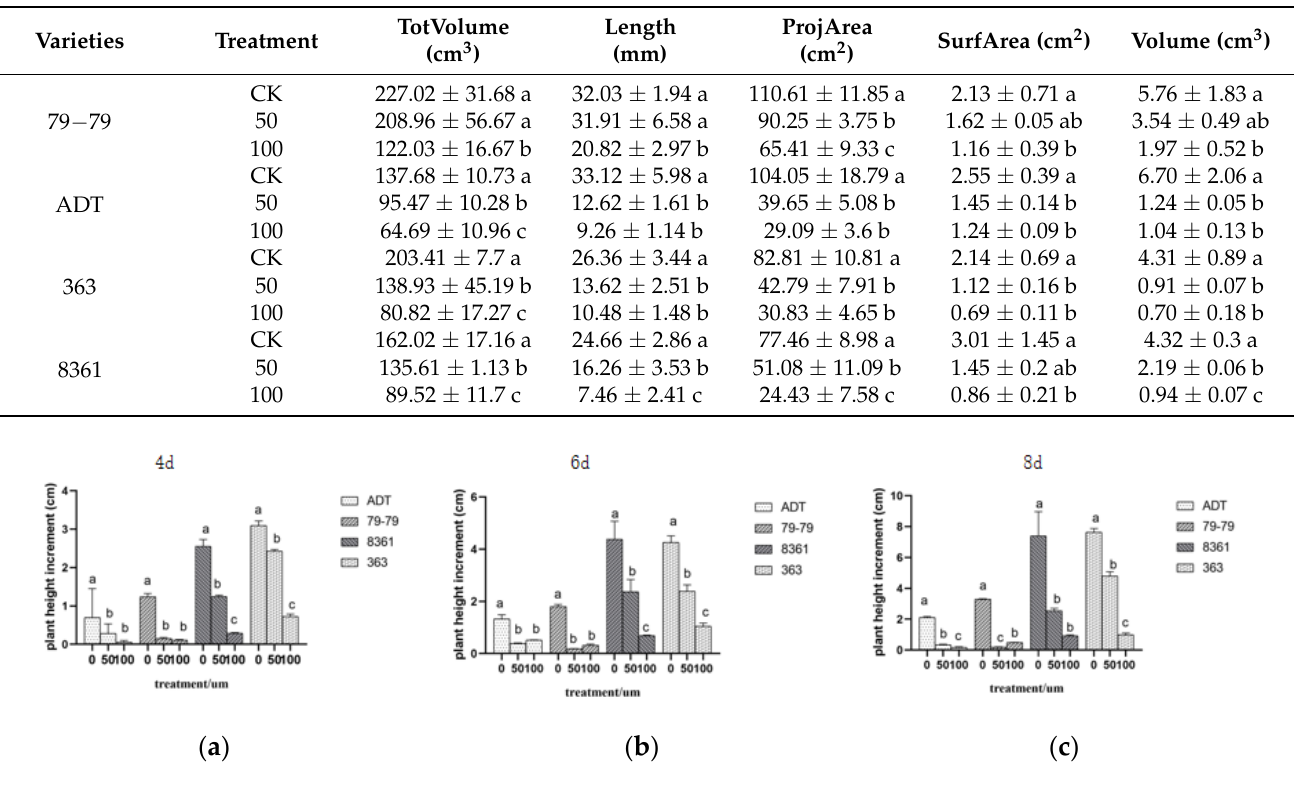
Table 1. TotVolume, length, ProjArea, SurfArea, and volume of sunflower root under different concentrations of cadmium. Different letters indicate significant differences between treatments ( p < 0.05, Duncan’s test).